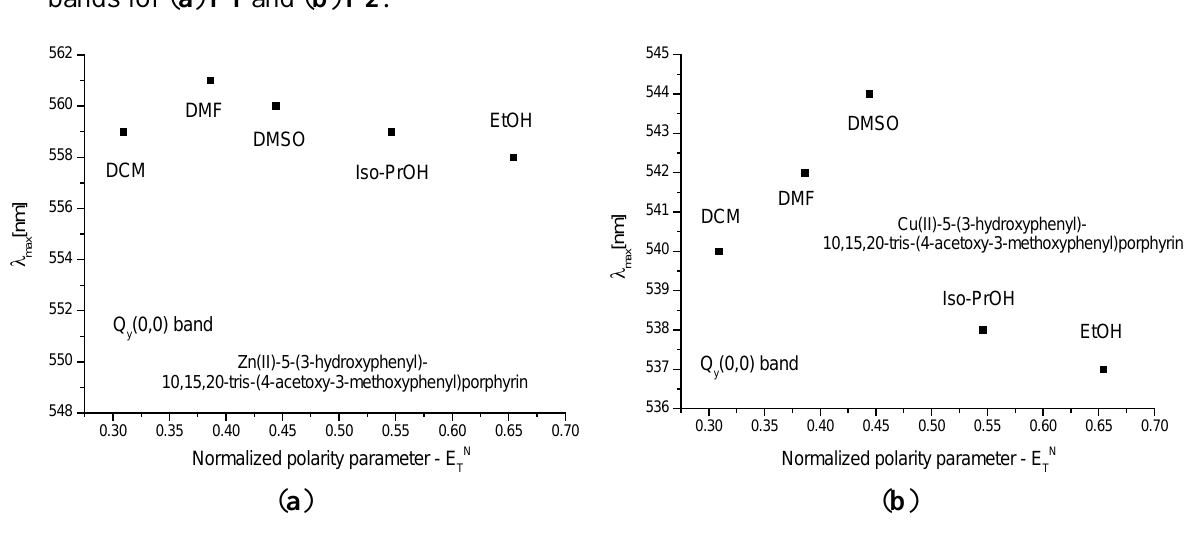
Figure 4. Reichardt’s normalized polarity parameter vs. wavelength maxima of the Qy(0,0) bands for ( a ) P1 and ( b ) P2